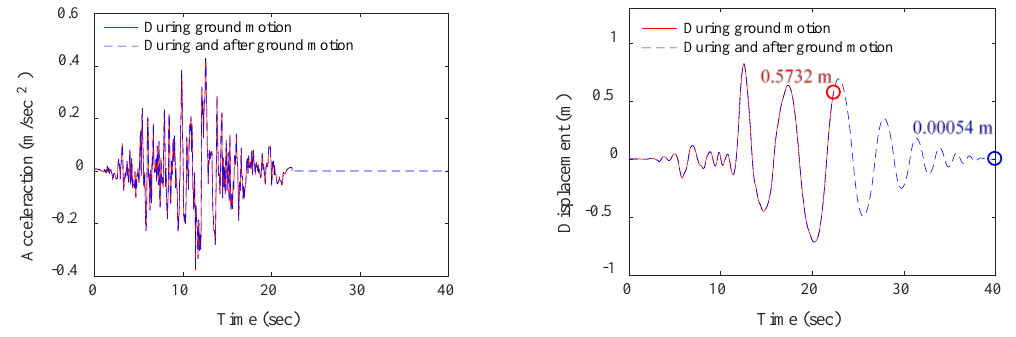
Figure 8. Displacement response histories and residual displacement of SRB-8 under the 1987 American Superstition, Parachute Test Site (225).